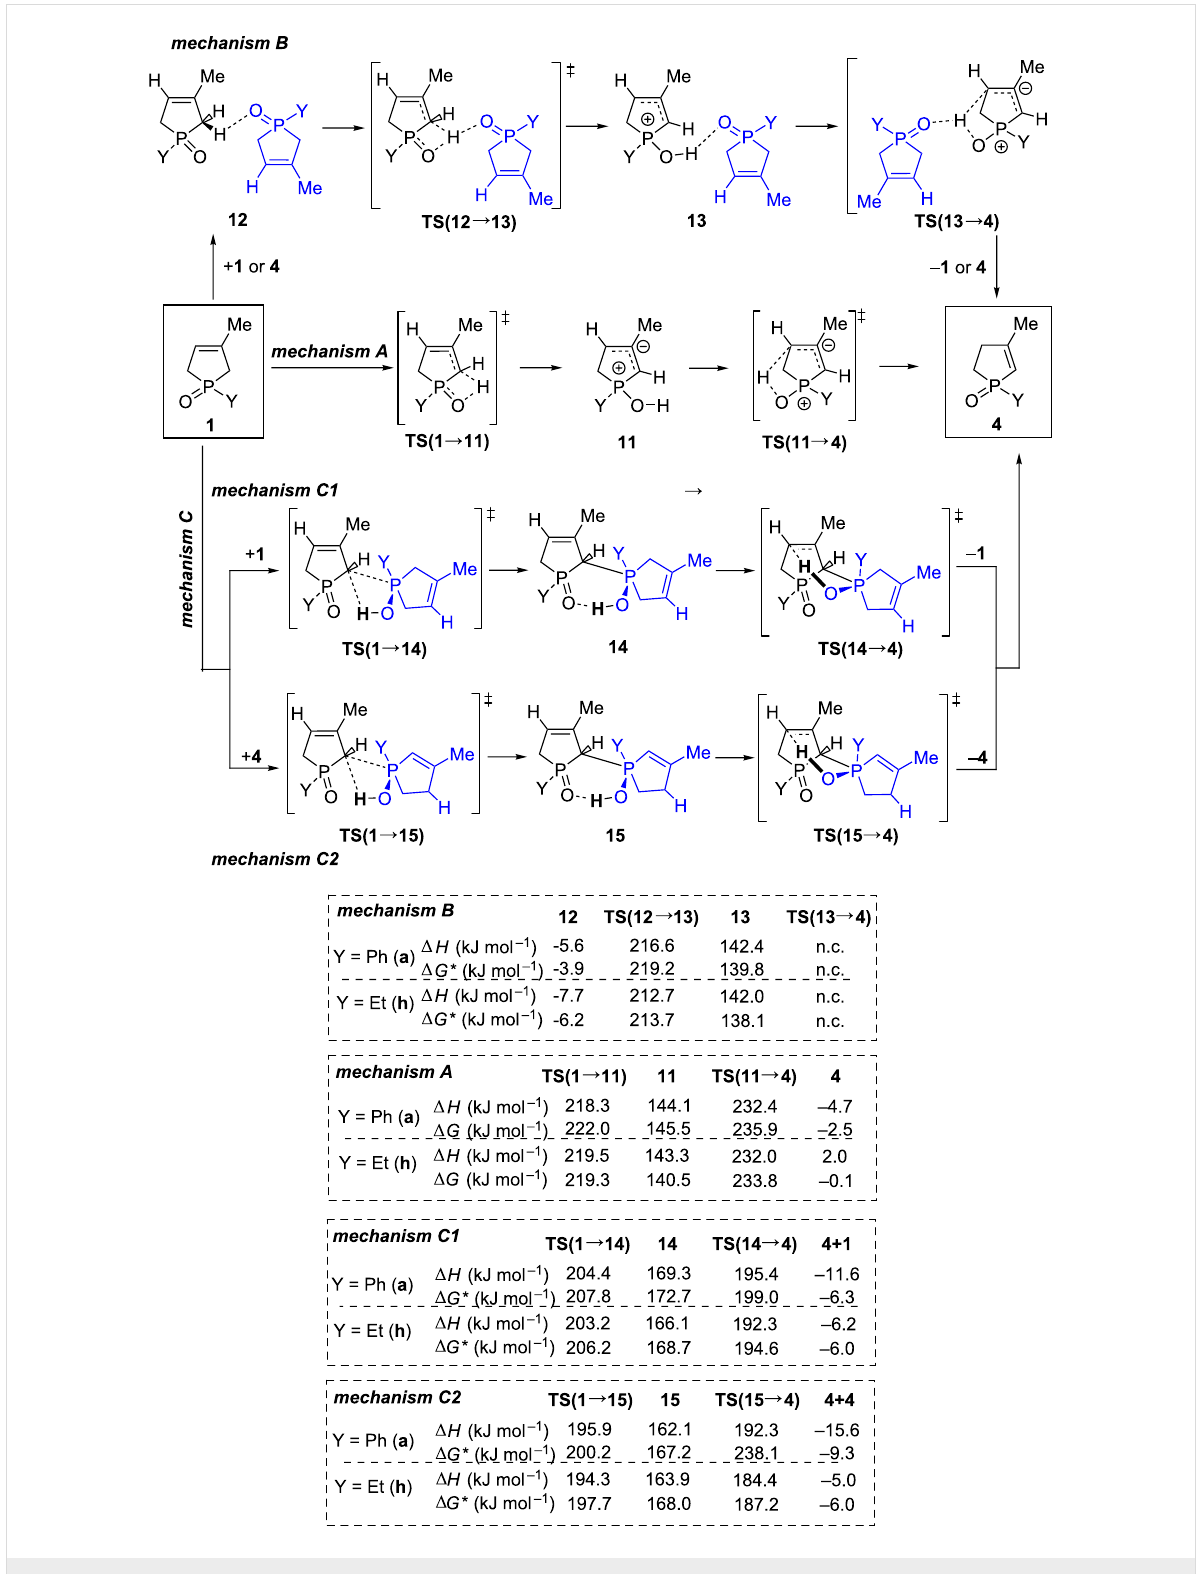
Scheme 2: Three possible reaction mechanisms considered in the theoretical studies for the isomerization of 3-phospholene oxides 1 under thermal conditions. *The calculated Δ G values for mechanism B and C were compensated by the dimerization entropy (ca. 128 J mol − 1 K − 1 ) due to the fact that the entropy obtained in vacuo calculations are not realistic in condensed